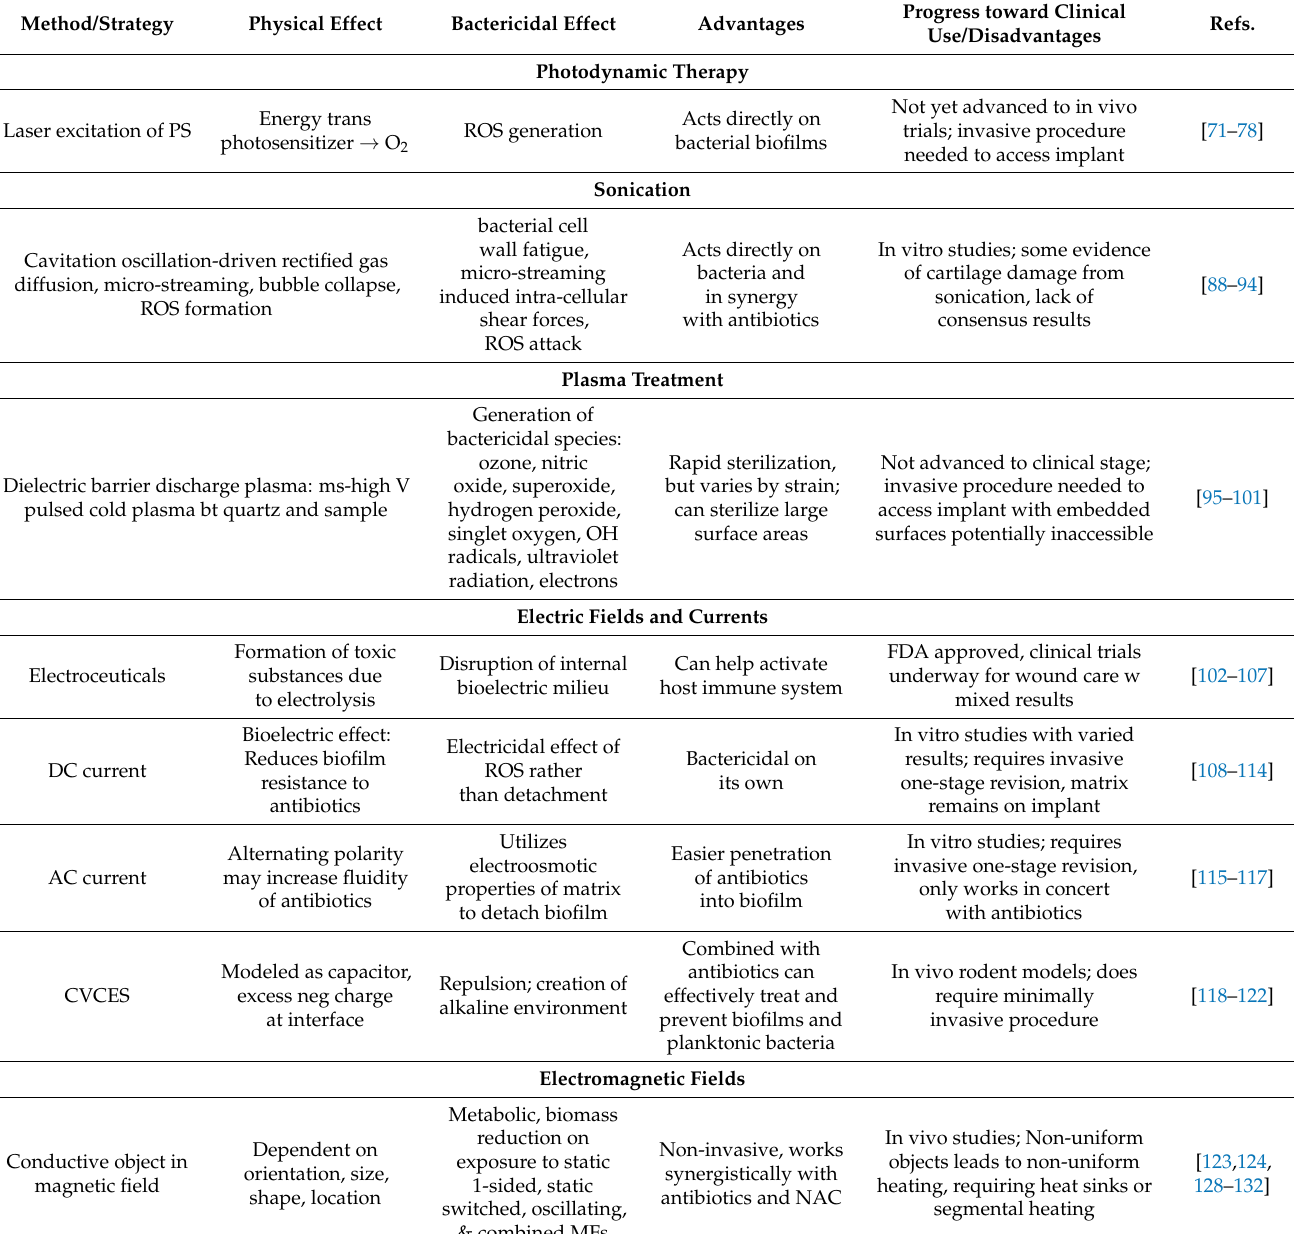
Table 2. Extrinsic methods. Methods that make use of external energy sources to treat